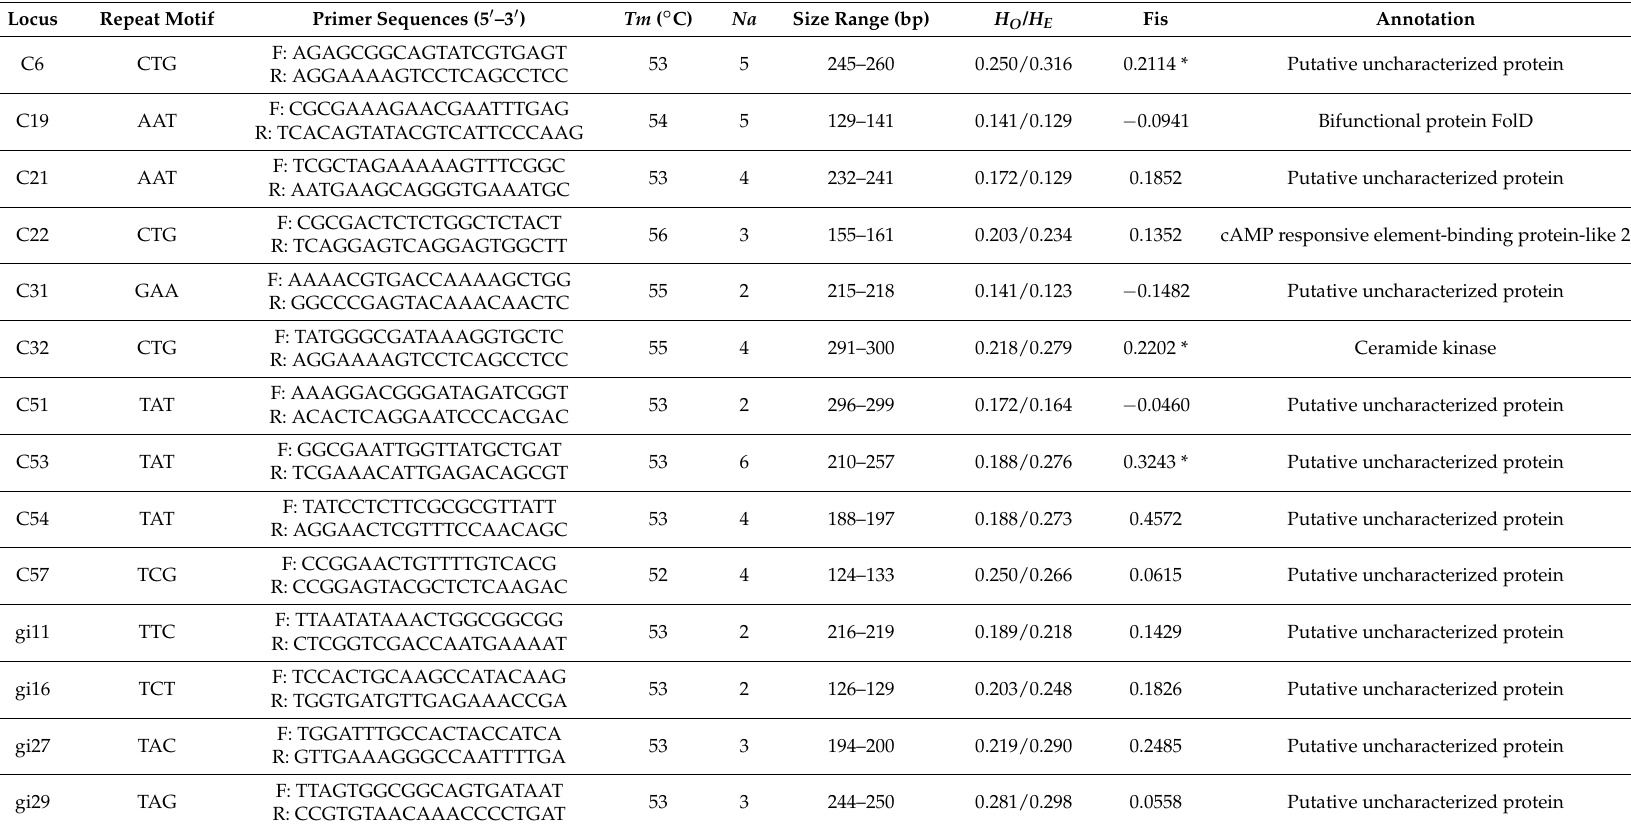
Table 1. Characterization of the 14 polymorphic microsatellite loci developed for C.